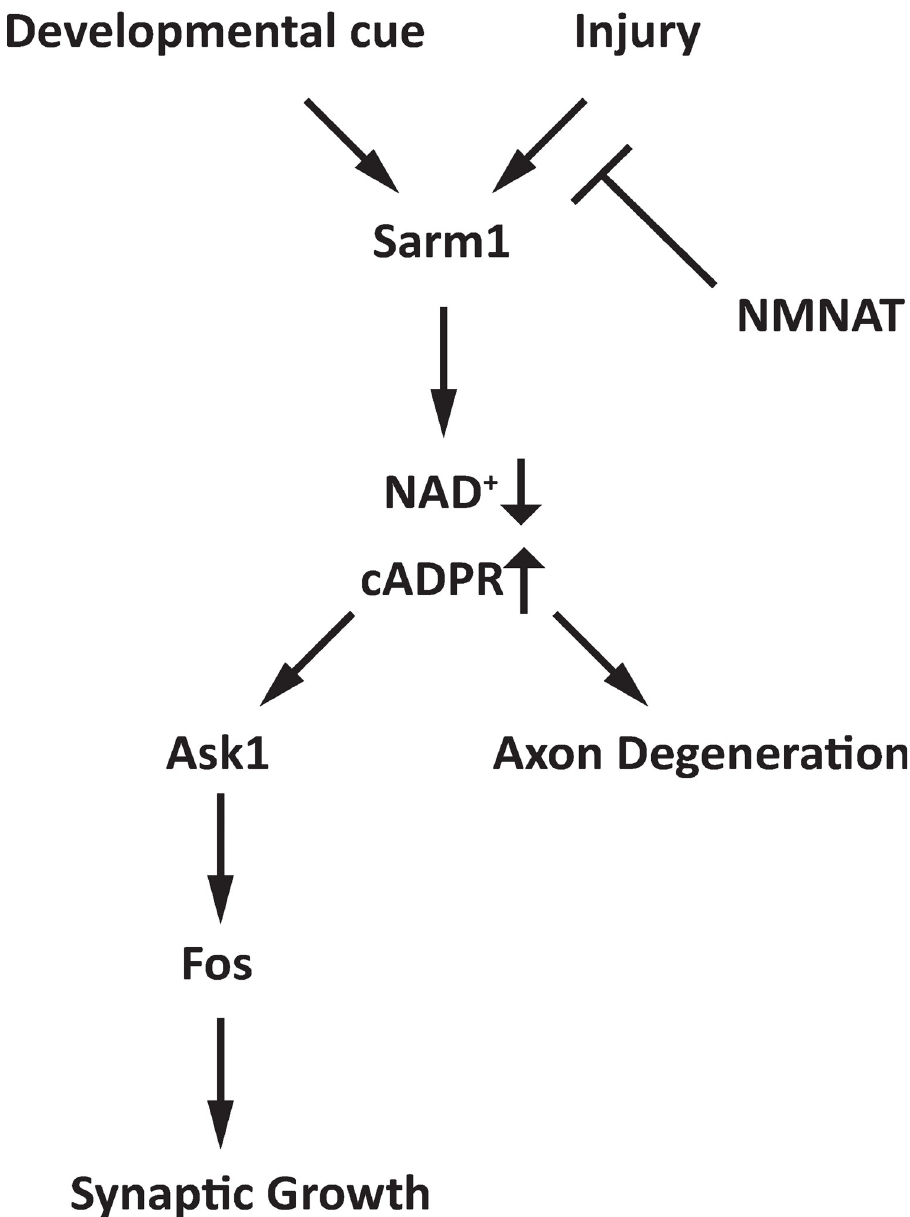
Fig 6. Model of dSarm1 regulation of axon degeneration and synaptic growth. Distinct upstream signals during development or after injury lead to dSarm1 activation. dSarm1 NADase activity is required for both axon degeneration and synaptic growth. The Ask1 MAPKKK pathway is necessary for dSarm1 regulation of synaptic growth, however, it is dispensable for axon degeneration.